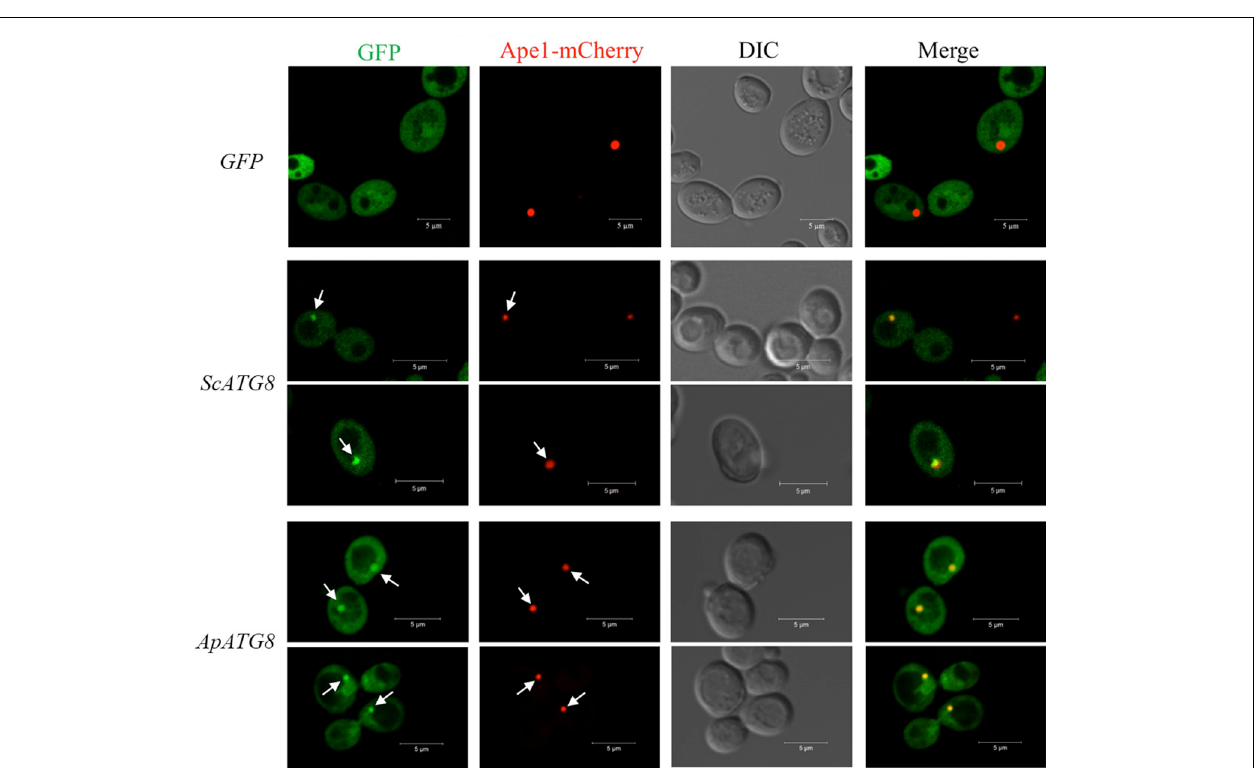
FIGURE 5 | In vitro lipidation of ApAtg8. In vitro conjugation reactions were performed at 30 ◦ C in the presence of purified yeast Atg3 (ScAtg3), Atg5, Atg7 (ScAtg7), ApAtg8 G118 (the processed form of ApAtg8 whose